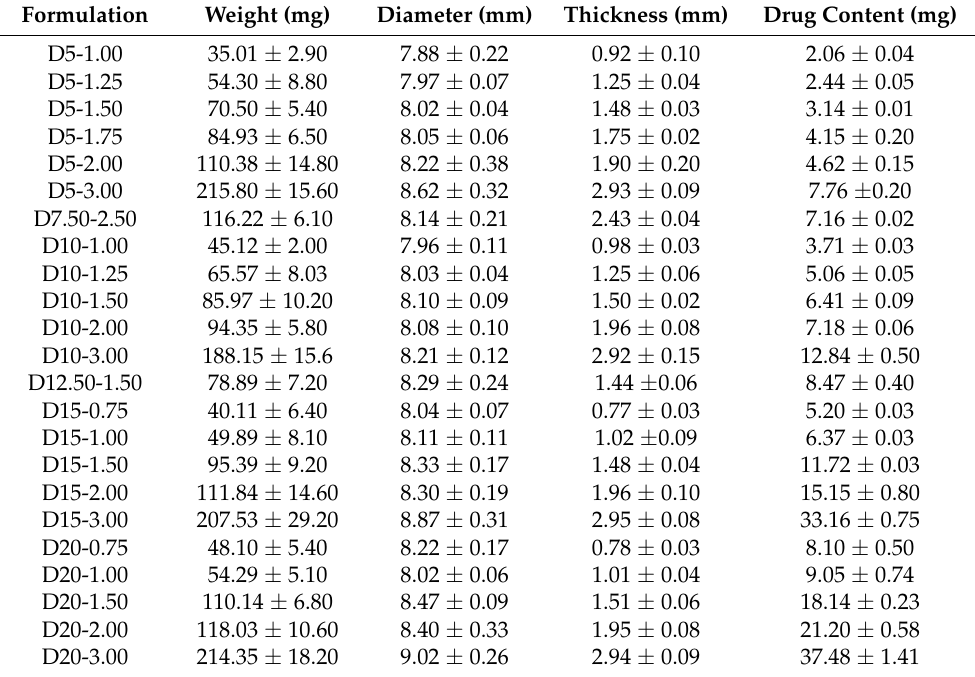
Table 1. Measured weight, diameter, thickness and drug content (mean ±